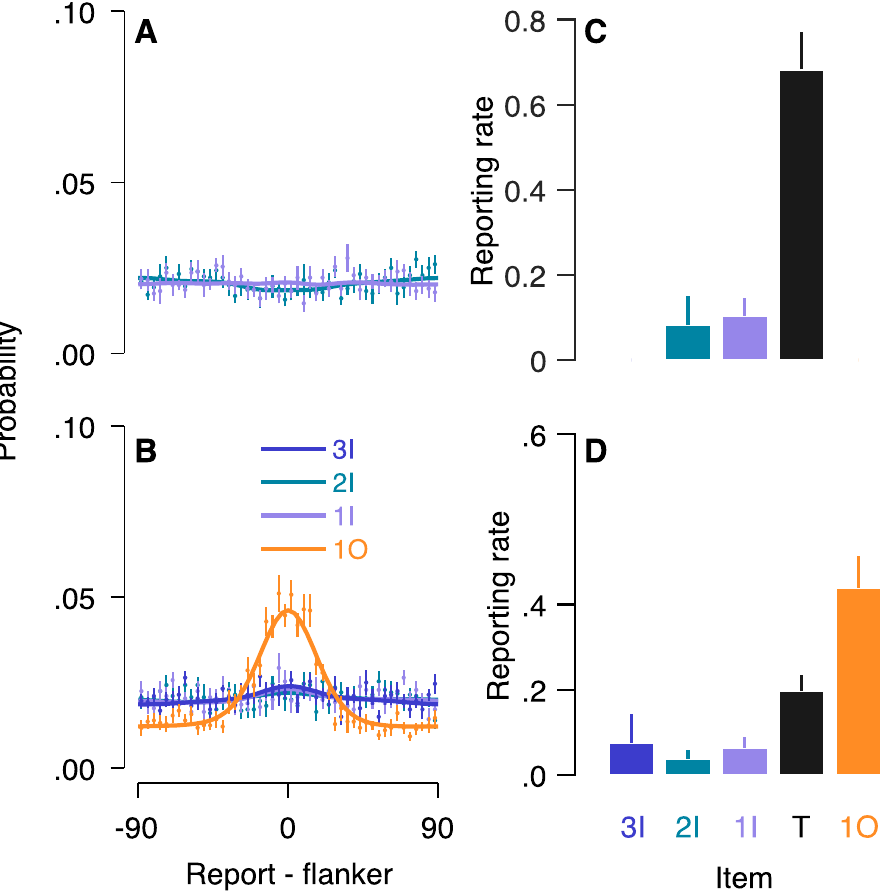
Figure 7. Misreporting the outer flanker as the target in “Experiment 2”. ( A , B ) Distribution of reports around the value of each flanker (0) for the ( A ) two-flanker and ( B ) four-flanker conditions, along with the fitting (solid lines) of the two-misreport and the four-misreport models respectively. ( C , D ) Reporting rates for each item in the two-flanker ( C ) and four-flanker ( D ) conditions. Flanker report rates are the fitted independent β to each flanker in the two-misreport ( C ) and the four-misreport ( D ) models. 3I 3rd Inner flanker, 2I 2nd Inner flanker, 1I 1st Inner flanker, T target, 1O 1 st outer flanker. Error bars are within subject ± 1